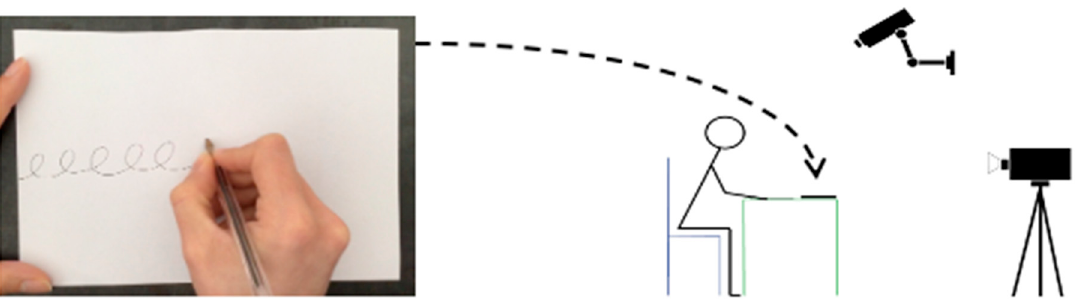
Figure 2. Experimental setting. A video model of a line of cycloid loops was displayed on an iPad placed in front of the child. The experimental features were collected with a video recording system and a digital pen. The task was performed on a free sheet of paper placed directly on the table.